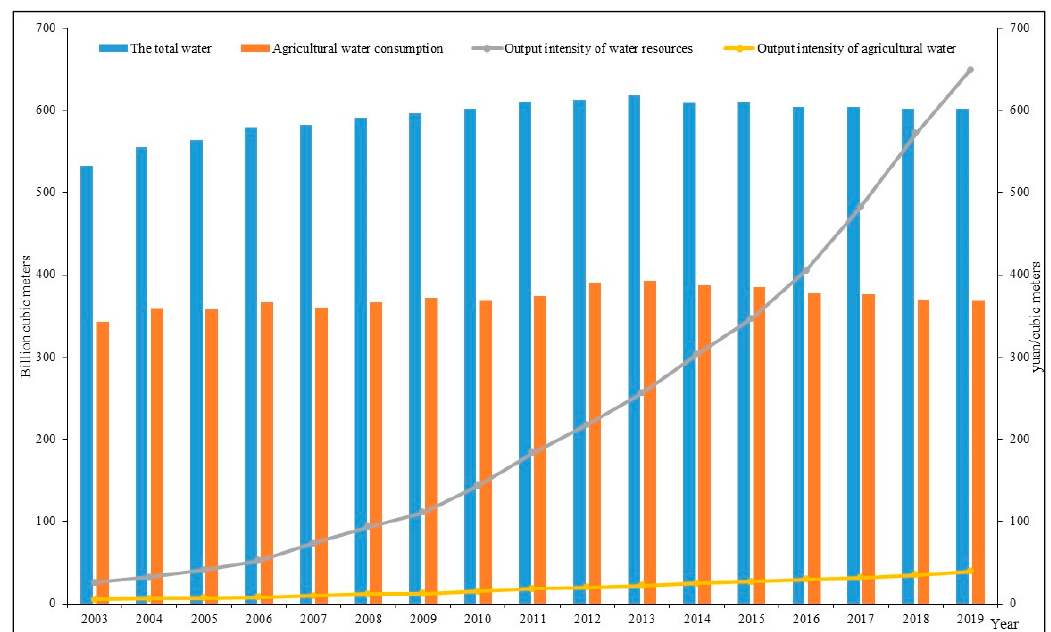
Figure 1. Changes in agricultural water consumption from 2003 to 2019.